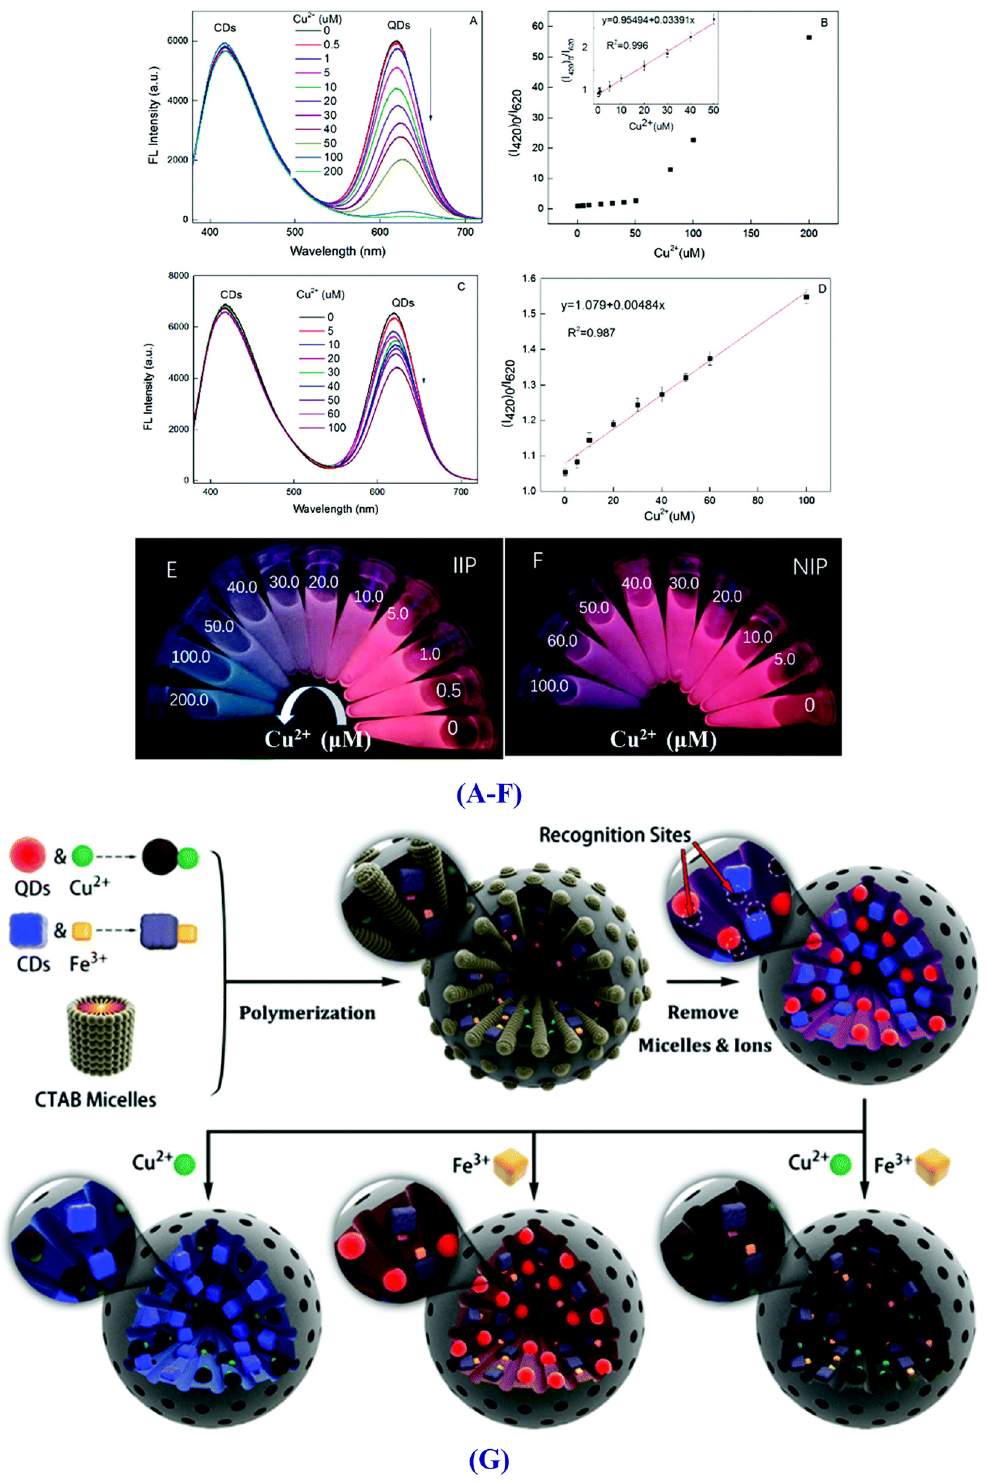
Figure 9: The fluorescence spectra of the ion-imprinted (A) and nonimprinted (C) fl uorescence polymers under exposure to different con- centrations of Cu(II). (B) and (D) are the plots of ( I 420 ) 0 / I 620 as a function of the Cu(II) concentration. (E) shows the photos of IIP detection solutionsunder365nmUV light,while(F)showsthephotosofNIPdetectionsolutionsunder365nmUVlight.(G)Schematicillustrationof the preparation of dual template ion-imprinted dual reference ratiometric fl uorescent (RF) probes to detect Fe(III) and Cu(II). Reprinted from Xu et al. ’ s work with the kind permission of The Royal Society of Chemistry [133]. Copyright (2019) The Royal Society of